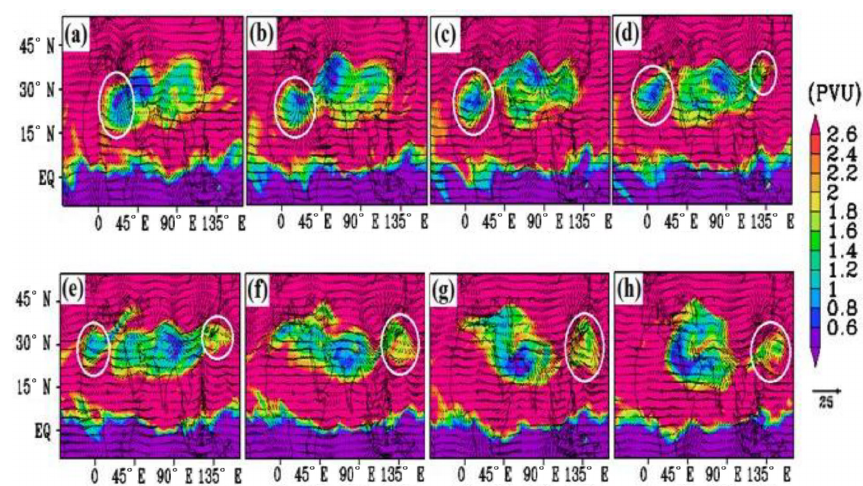
Figure 1. Spatial distribution of potential vorticity (PVU) (1 PVU = 10 − 6 Km 2 kg − 1 s − 1 ) (colour shades) at 370K potential temperature surface and wind anomalies at 200hPa from ERA-Interim reanalysis for (a) 1 July, (b) 2 July, (c) 3 July, (d) 4 July, (e) 5 July, (f) 6 July, (g) 7 July and (h) 8 July 2003. Wind vectors are represented by black arrows (ms − 1 ). Eddies are shown with white circles.